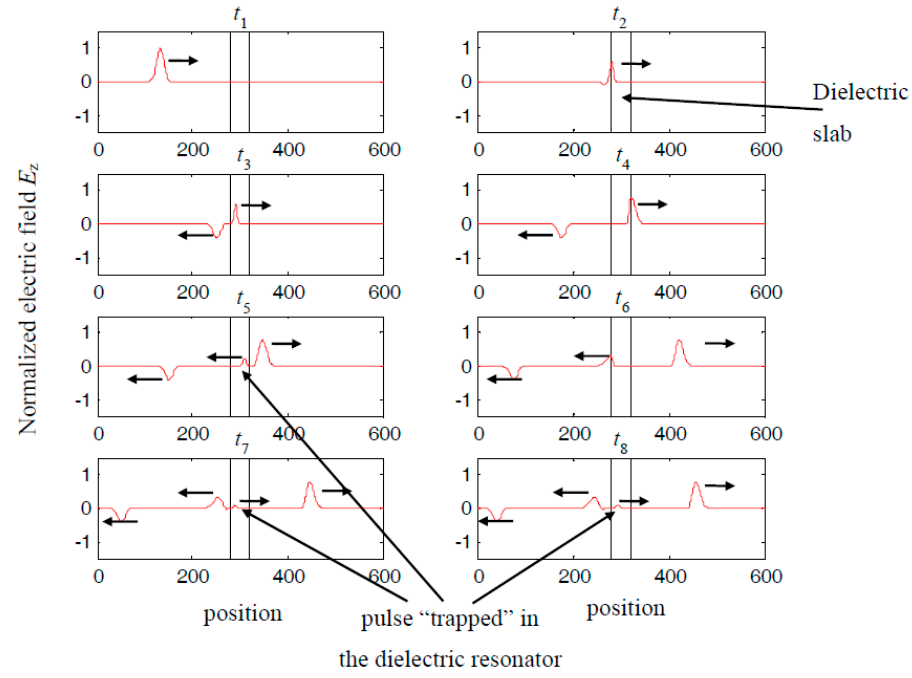
Figure 4. Interaction of the Gaussian pulse with single dielectric layer; results of the 1D FDTD simulation for various time instances.